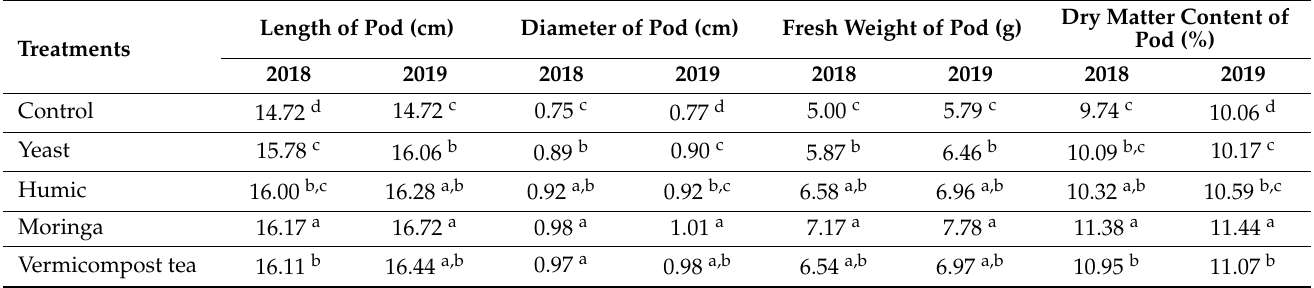
Table 7. Effect of different biostimulant extracts on pod quality of green bean in growing seasons of 2018 and